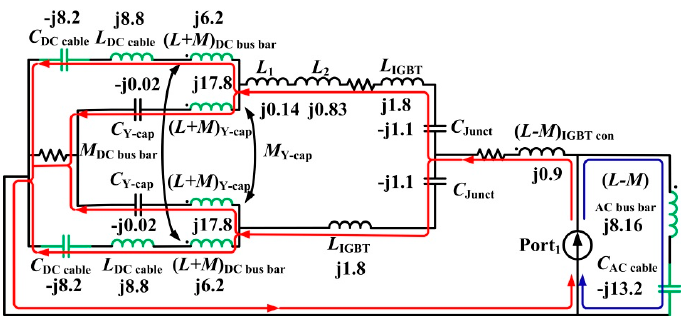
Figure 7. Current ‐ following path at 11 MHz.